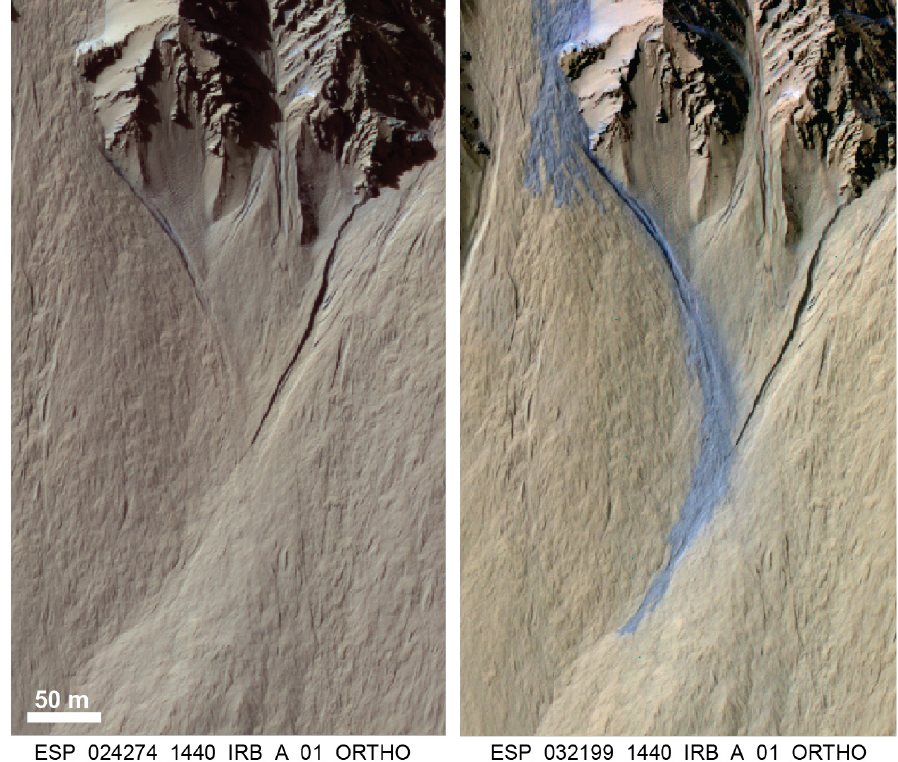
Figure 16. Gully activity in Gasa crater (35.74 ◦ S, 129.42 ◦ E) observed in HiRISE IRB images separated by nearly one Mars year. The color makes the changes more obvious. However, the mass movement is not resolvable in topographic data even though small topographic changes are visible. Both images are orthorectified to DTEEC_021584_1440_022217_1440_A01. North is to the top of the page, illumination from upper